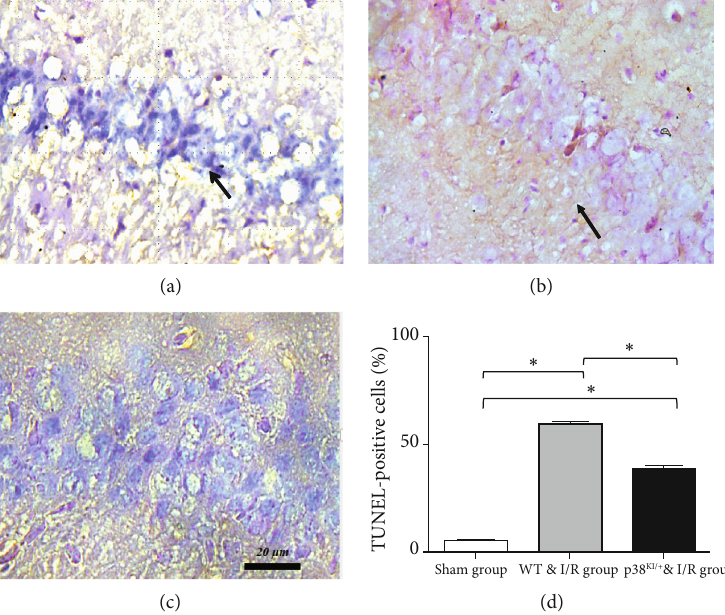
Figure 6: p38 MAPK knockdown rescues apoptosis and DNA damage after cerebral ischemia and reperfusion. (a) TUNEL staining photomicrographs at 3 days after cerebral ischemia/reperfusion in the WT & I/R group. (b) TUNEL staining photomicrographs at 3d after cerebral ischemia and reperfusion in the p38 KI/+ & I/R group. (c) TUNEL staining photomicrographs in the sham group by TUNEL staining. (d) Apoptotic TUNEL-positive cells (%) of TUNEL staining in hippocampal CA1; the p38 KI/+ & I/R group was lower than the WT & I/R group, respectively ( n = 3 per group; ∗ p < 0 : 05 , sham group vs. I/R group; ∗ p < 0 : 05 , p38 KI/+ & I/R vs. I/R group.). The slice thickness is 16 μ m under a × 400 microscope image (red brown indicates Klenow- or TUNEL-positive cells by black arrows; blue depicts nucleus; scale bars 20mm). ∗ p < 0 : 05 by one-way ANOVA.